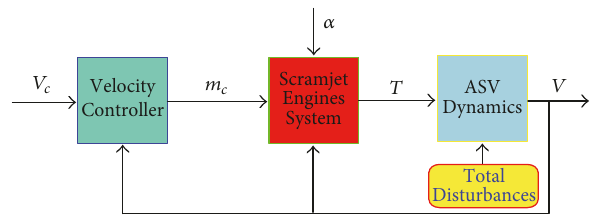
Figure 1: Velocity control process of ASV